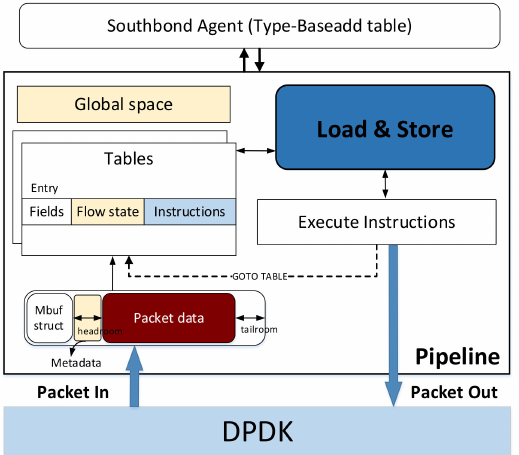
Figure 6. Pipeline design based on the DPDK framework that allows multi-type data